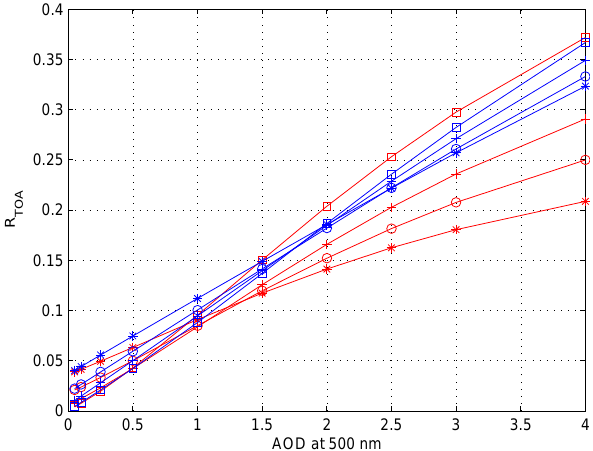
Figure 2. Modelled top-of-atmosphere (TOA) reflectances for the sea salt (blue) and dust (red) coarse aerosol components as function of the reference AOD at 0.500µm. The wavelength dependency of reflectance is indicated by symbols: star 0.555µm, circle 0.659µm, plus 0.865µm, and square 1.610µm. In this example the geometry is set to a solar zenith angle of 30 ◦ , a satellite viewing zenith angle of 5 ◦ (near nadir), and a relative azimuth angle of 10 ◦ .